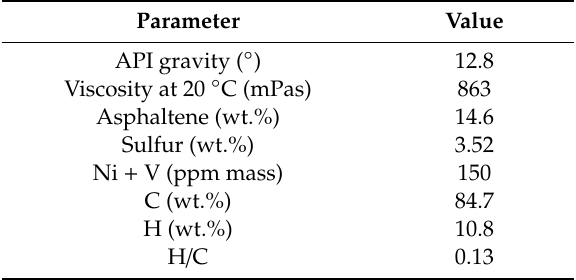
Table 2. Properties of Toe-to-Heel Air Injection (THAI) heavy